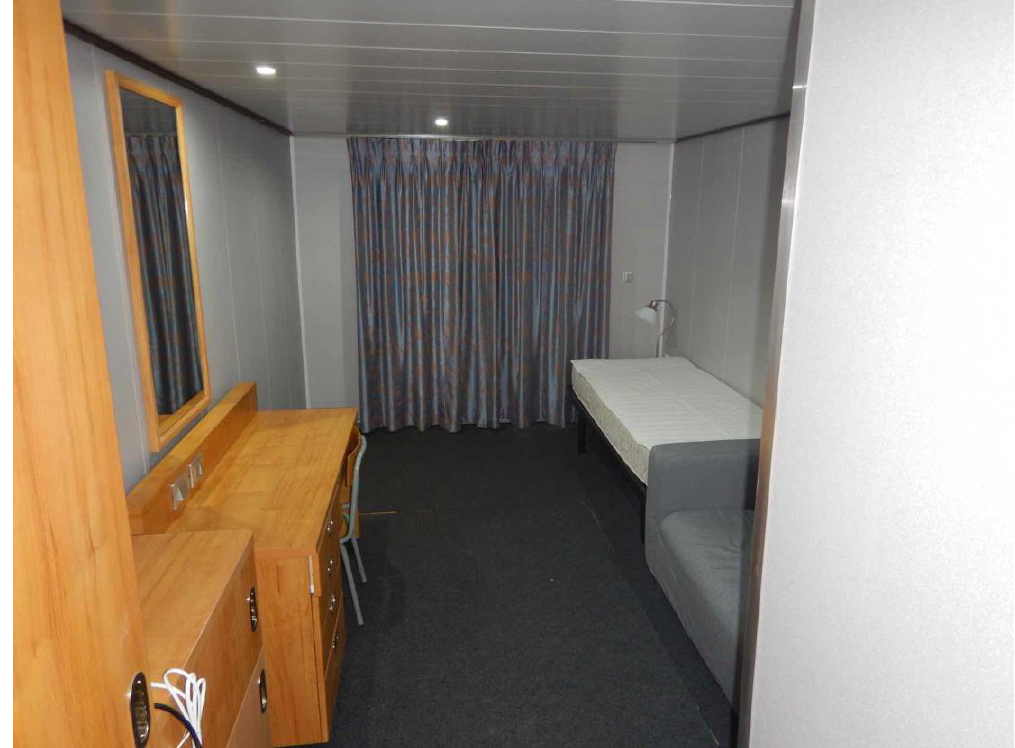
Figure 3. A view of the test cruise cabin.